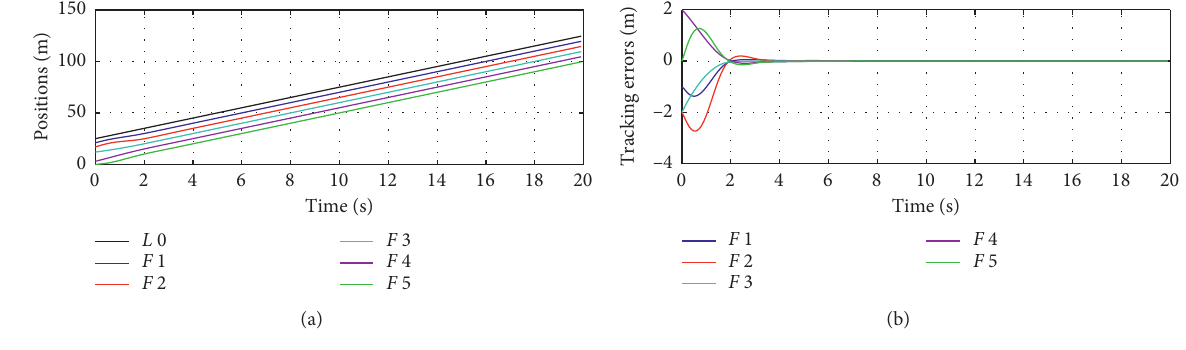
Figure 2: Positions and tracking errors of the